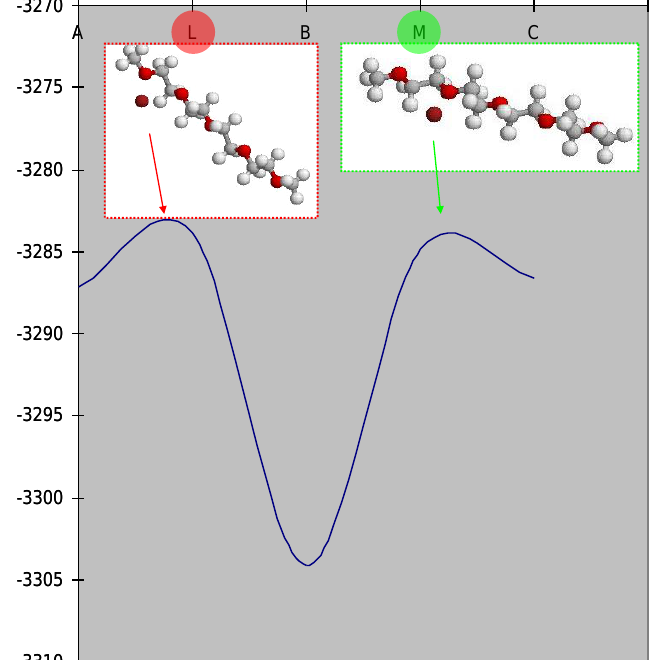
= −3,283.80 kkal·mol −1 and E = −3,287.19 kkal·mol −1 ) L M